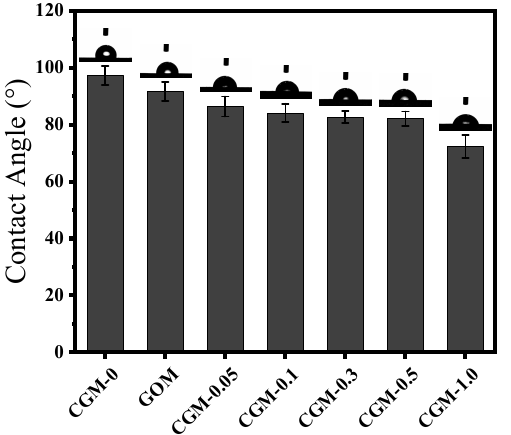
Figure 8. Water contact angle of different membranes. The pore structure parameters of different membrane surfaces measured by gravime- try are shown in Table 3. Both the modified membranes had a higher porosity and average pore size than the membranes without modifiers. It can be noticed that after adding GO to the PES matrix, the porosity increased by 2% and the average pore size increased by 1.6 nm, indicating that adding hydrophilic GO can enhance the thermodynamic instability of the casting solution, thereby shortening the liquid–liquid stratification delay time during the phase separation process, achieving better porous structures. The porosity and average pore size of the membranes gradually improved when the amount of CAB − GO addition increased. When the addition of CAB − GO reached 0.5 wt%, the porosity and average pore size of the membrane reached their maximum values, which were 63.44% and 14.73 nm, respectively. Because of the stronger hydrophilicity, which is beneficial to the DMAc solu- tion into the pure water, the CAB − GO can move rapidly to the membrane surface during the phase separation, increasing the porosity and average pore size of the ultrafiltration membrane [42]. The porosity of CGM-1.0 decreased slightly (63.00%) due to the increase in solution viscosity, while the addition of CAB − GO exceeded 0.5 wt% [43].